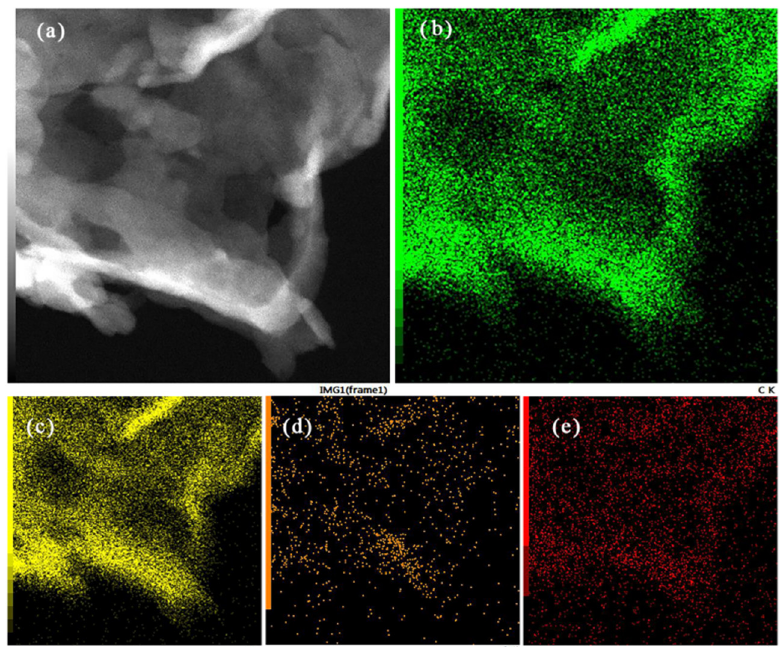
Figure 3. ( a ) The TEM image of 0.5% Co 3 O 4 /g-C 3 N 4 . ( b – e ) Elemental maps of the catalyst: ( b ) C, ( c ) N, ( d ) Co and O elements.